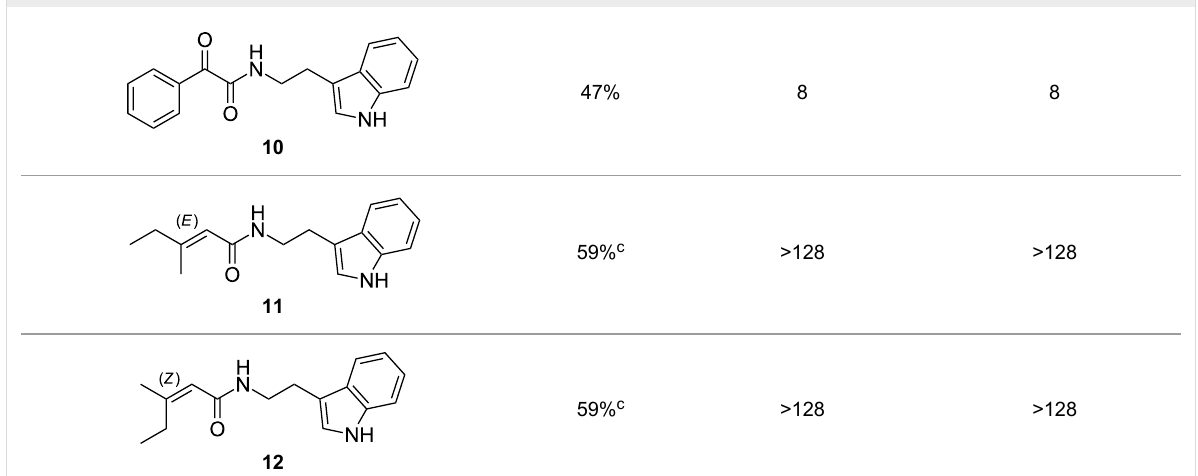
Table 1: Summary of synthesized nematophin derivatives ( 1 – 12 ) and their bioactivity (MIC in µg/mL) against S. aureus (MSSA and MRSA).